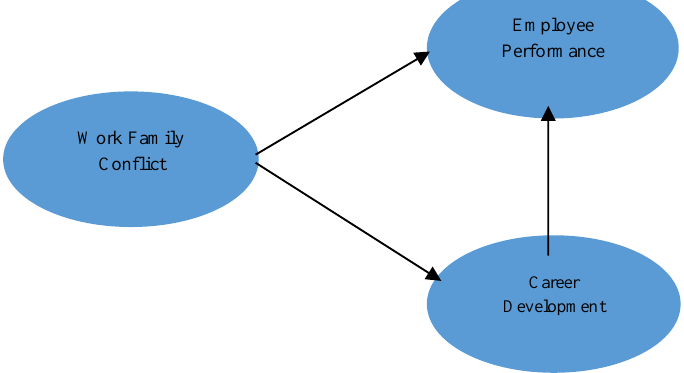
Figure 1 . Framework of Research